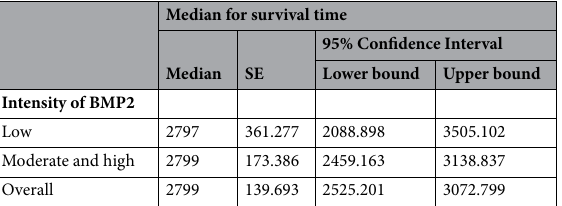
Table 1. Mean survival times among patients with and without high BMP2 expression levels. Significance was determined by the Log-rank test ( p = 0.603).